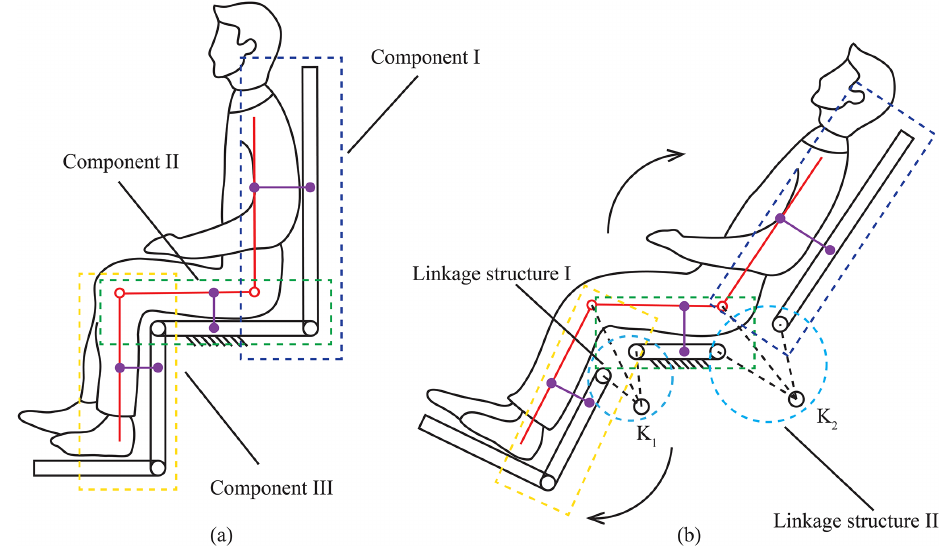
Figure 2. Human–wheelchair coupling model II. (a) Human–wheelchair coupling model in the sitting posture. (b) Human–wheelchair coupling model in the sit-to-lie